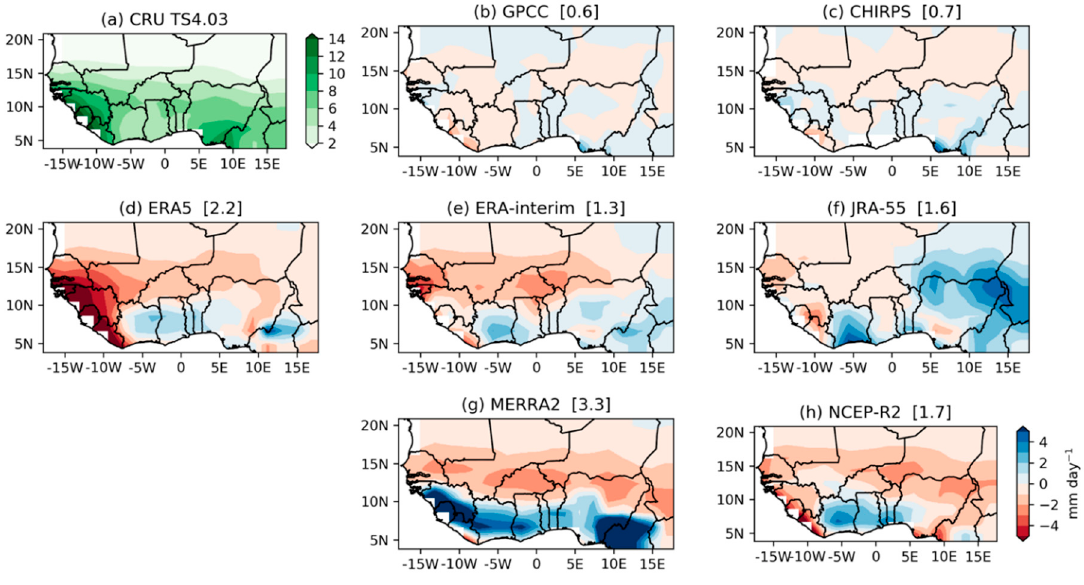
Figure 2. Spatial distribution of mean JJAS precipitation (mm day − 1 ) over West Africa for three observations ( a – c ); CRU, GPCC, and CHIRPS, and five reanalysis datasets ( d – h ). Plot shows mean di ff erences from CRU for the 1981–2016 period. Standard deviations of the mean rainfall bias are shown in box brackets. JJAS—June–September; CRU—Climate Research Unit; GPCC—Global Precipitation Climatology Centre; CHIRPS—Climate Hazards Group InfraRed Precipitation with Stations.